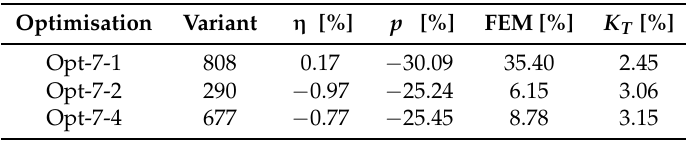
Figure 29. FEM simulation of hydrodynamic and centrifugal loads of manual design and converged optimal solutions in Group 1. ( a ) Opt-7 benchmark; ( b ) Opt-7-1; ( c ) Opt-7-2; ( d ) Opt-7-4. Table 16. Converged optimal solutions, relative to benchmark design.